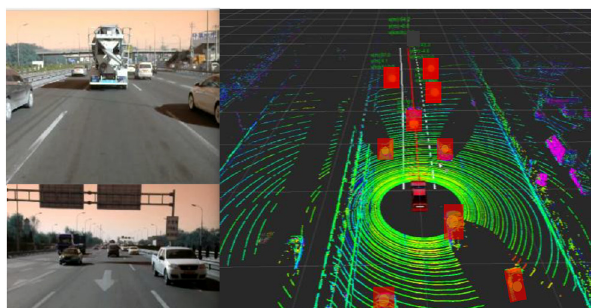
Figure 12 Scenario case with the fusion results in red bounding boxes